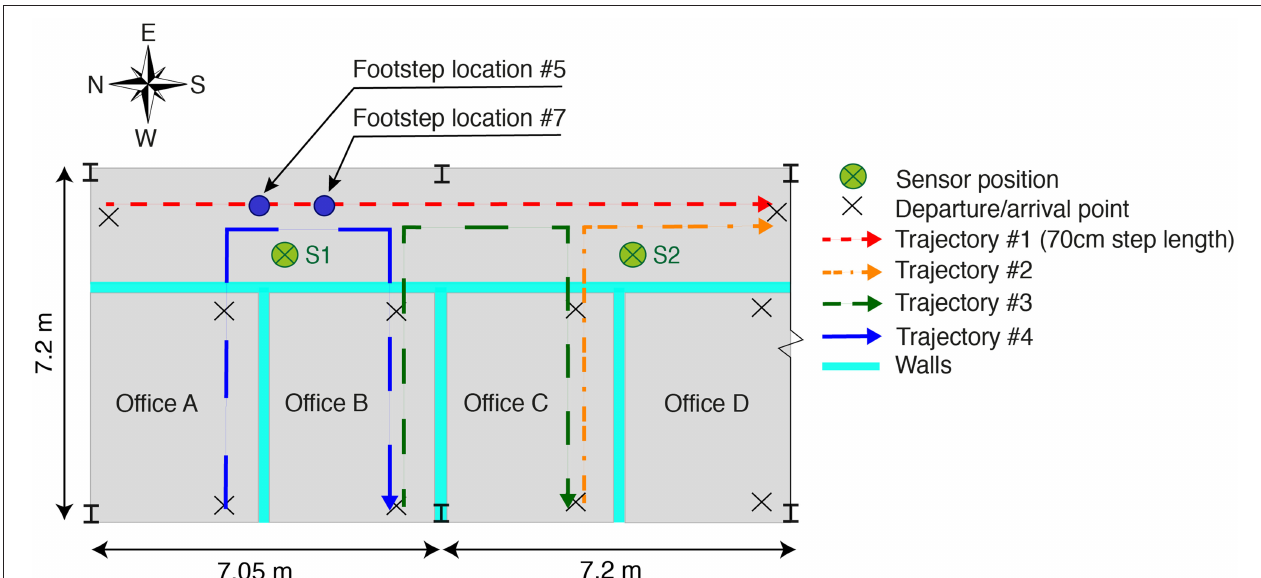
FIGURE 4 | Offices A, B, C, and D as well as the corridor are considered for occupant tracking ( ∼ 100 m 2 ). The corridor and each office contain two departure/arrival points for trajectories. Trajectories #1, #2, and #3 are used for occupant tracking using model-based approaches (see Figures 9 – 11 ). Trajectory #4 is measured prior to the localization tests in order to assess measurement uncertainty (see Figure 8 ). Footsteps #5 and #7 are used to demonstrate the limitation of occupant localization using model-free approaches (see Figure 14